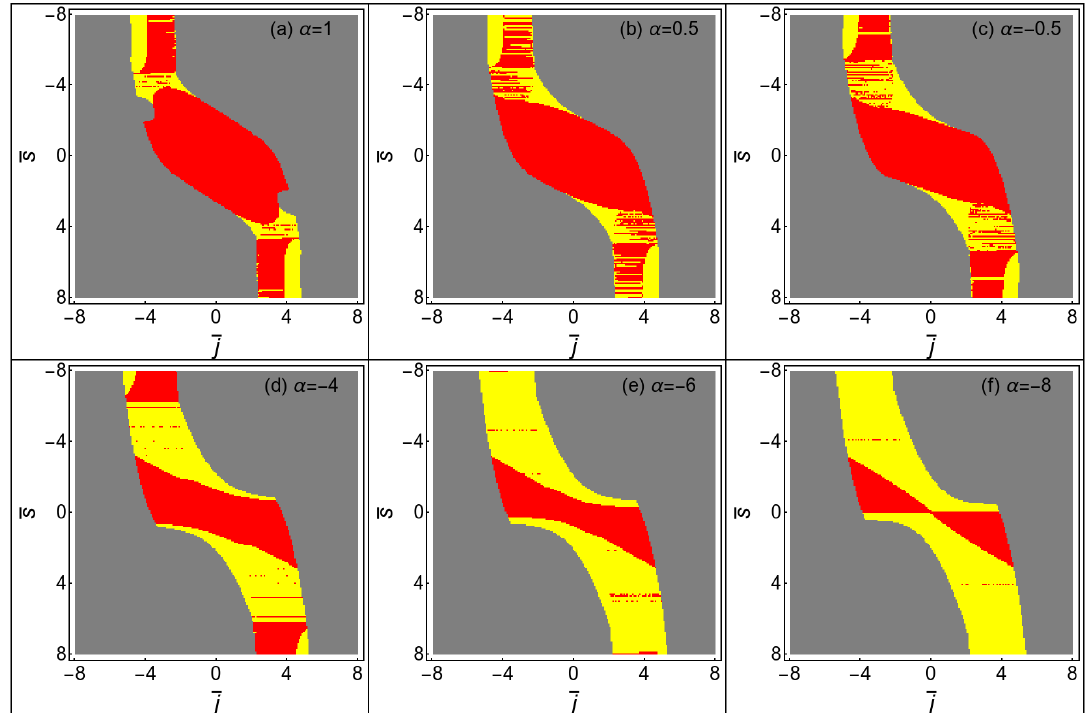
Figure 4. Properties of circular orbits for the spinning test particle in the four-dimensional GB black hole background. Here ¯ l = ¯ j − ¯ s is the orbital angular momentum. The parameters are set as M = 1 and m = 1. In the gray region, the test particle can have timelike circular orbits. In the red and yellow regions, the test particle does not have stable timelike circular orbits. In the yellow region, the motion of the test particle is spacelike and